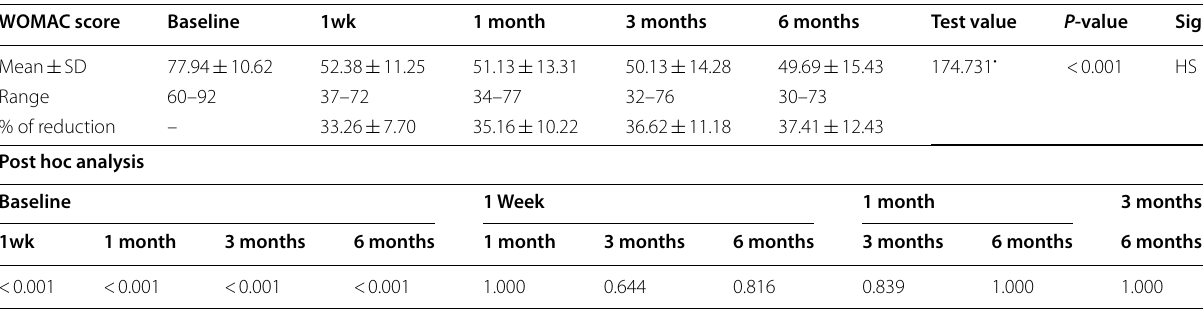
Table 2 Comparison between the baseline WOMAC score and its follow-up at 1 week, 1, 3 and 6 months after embolization